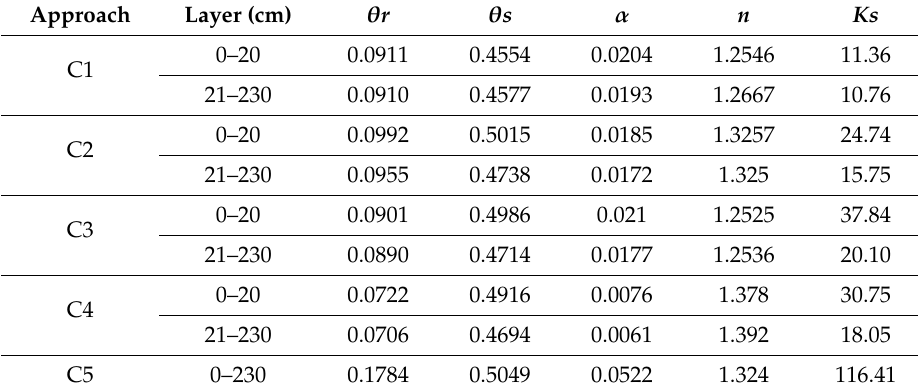
Table 2. Van Genuchten parameters of the five approaches.